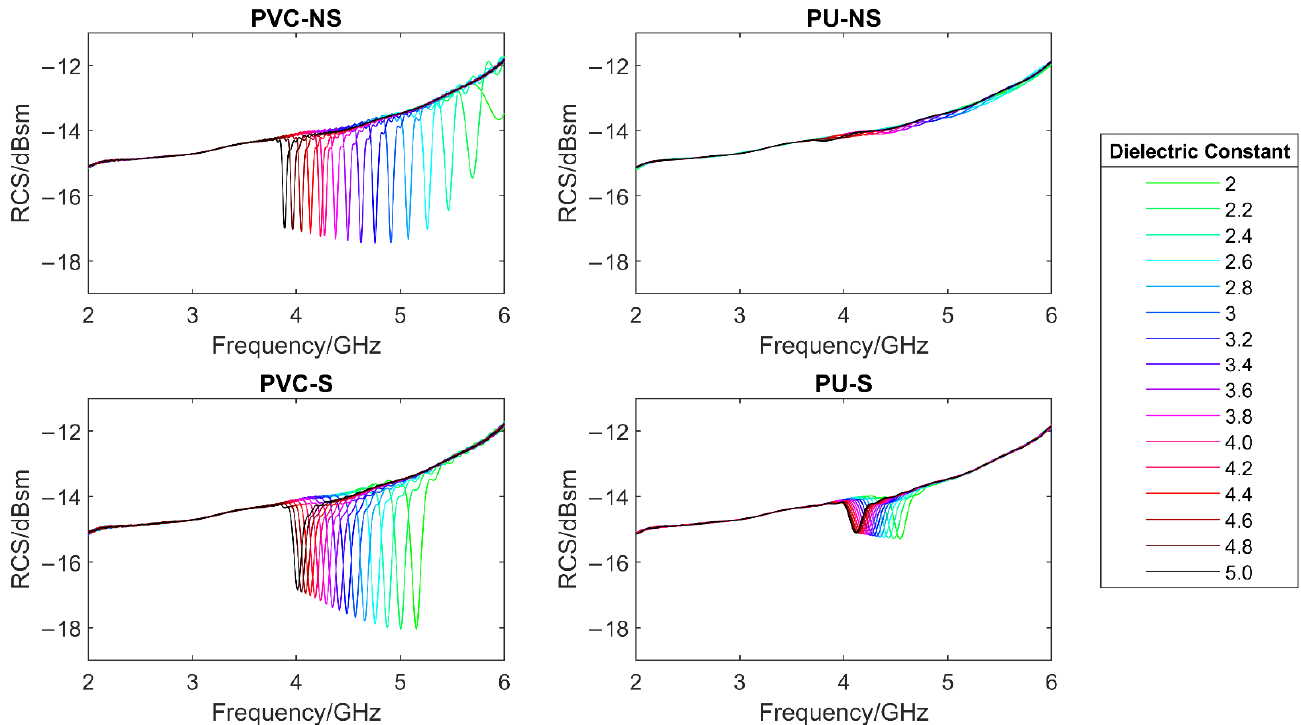
Figure 12. The effect of changes in the dielectric constant of the paint layer on the simulated RCS response.